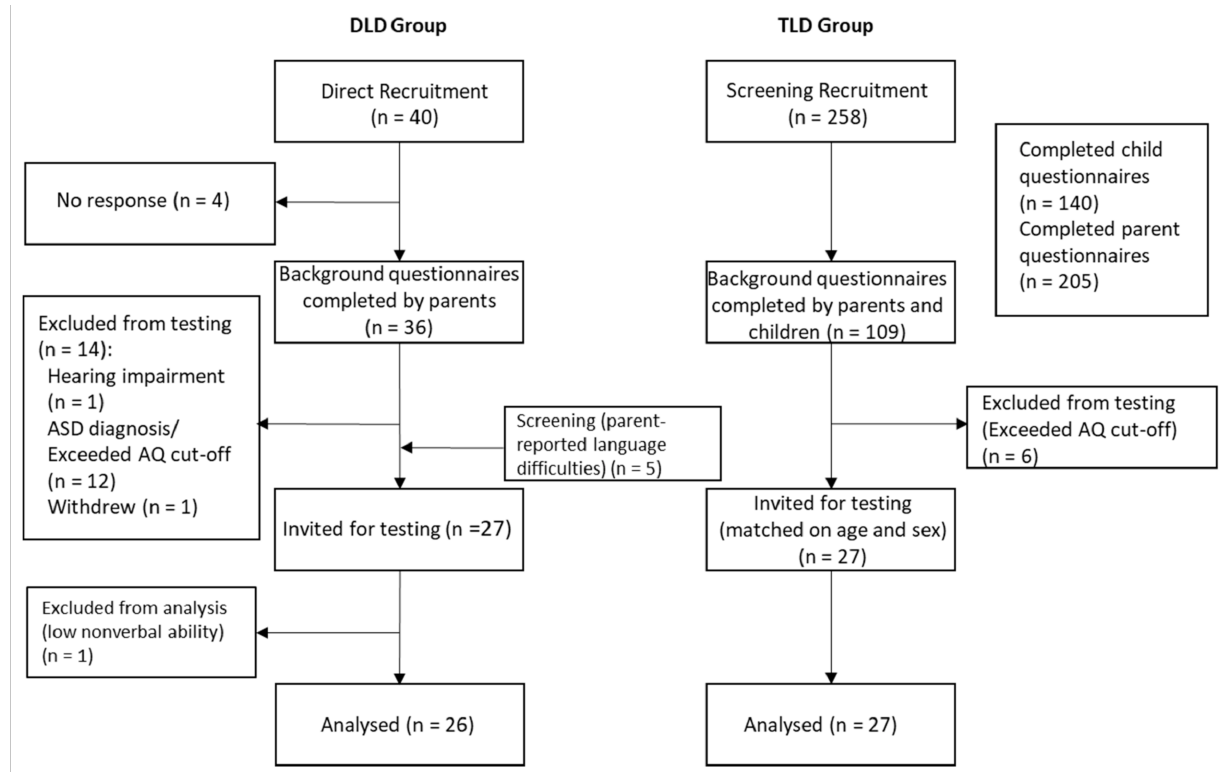
Figure 2. Flowchart of participant recruitment. AQ, Autism Quotient; ASD, Autism Spectrum Disorder; DLD, Developmen- tal Language Disorder; TLD, Typical Language